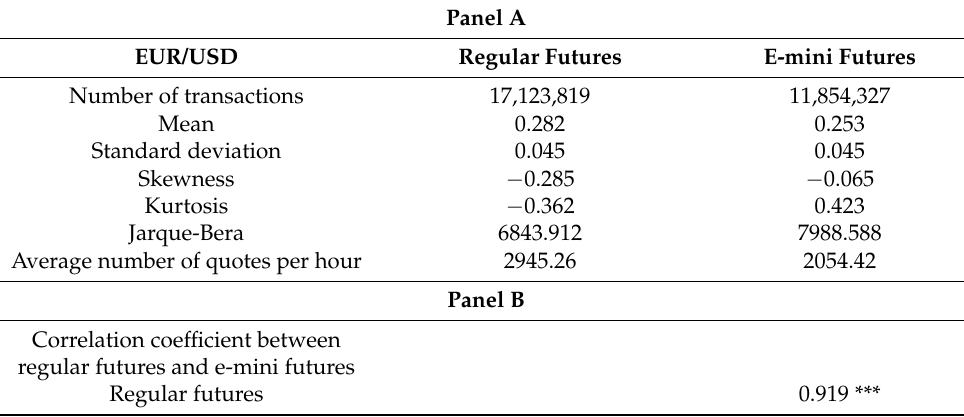
Table 1. Summary